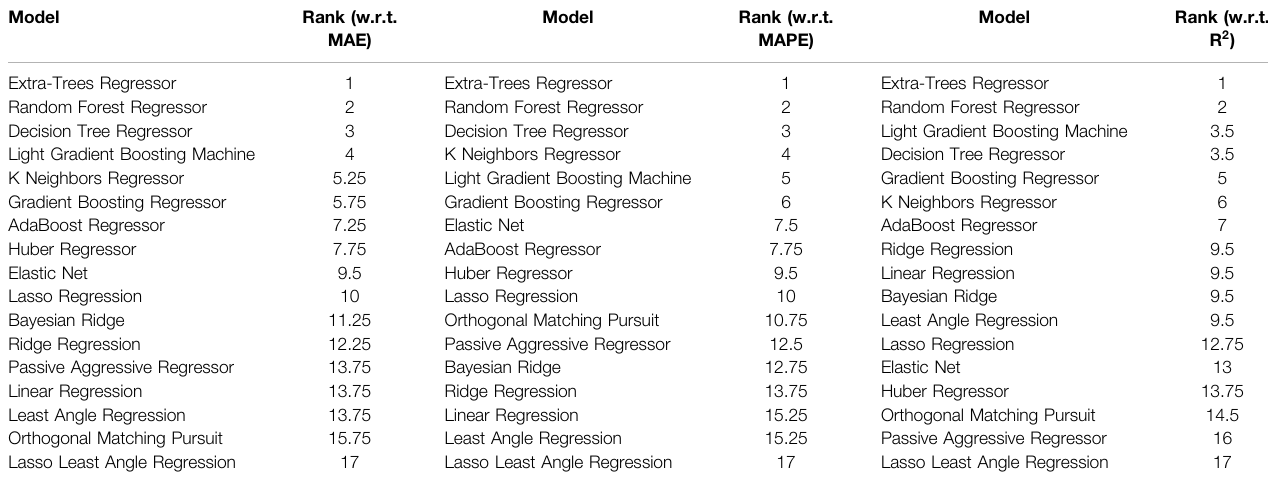
TABLE 6 | Friedman